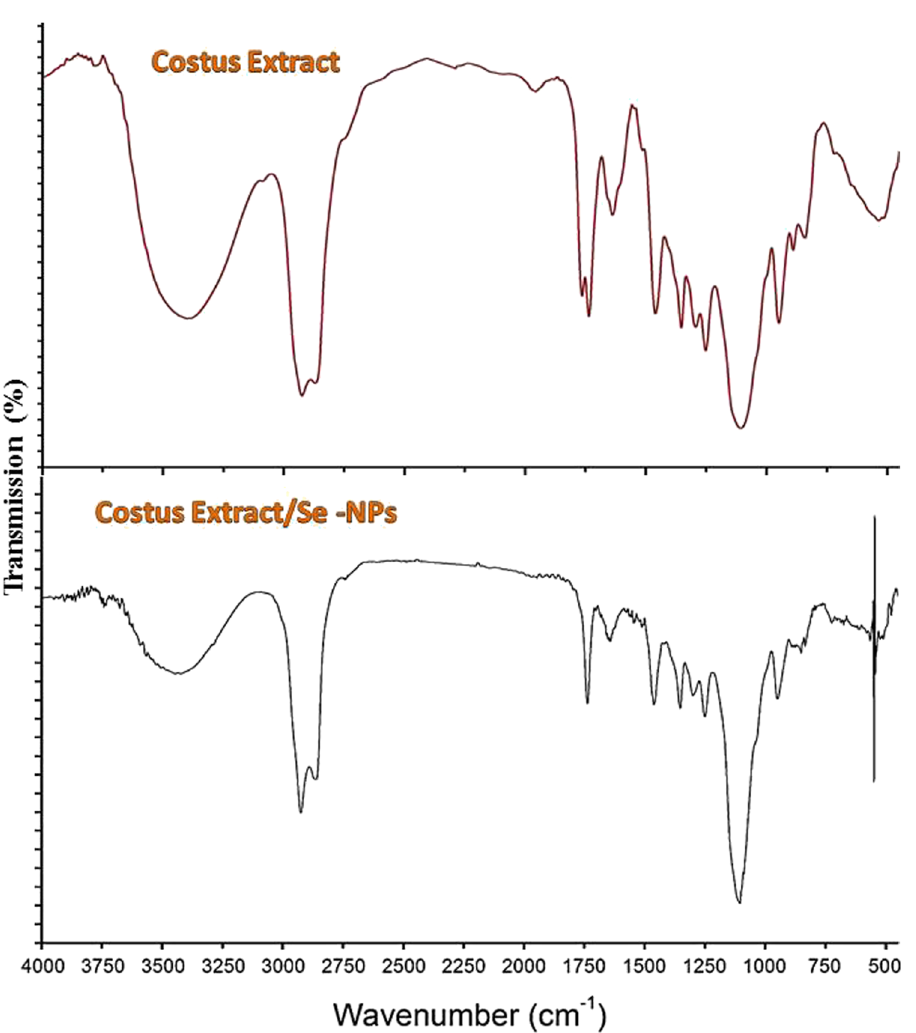
Figure 1: FTIR spectra of SCE and the phytosynthesized Se - NPs with this extract.